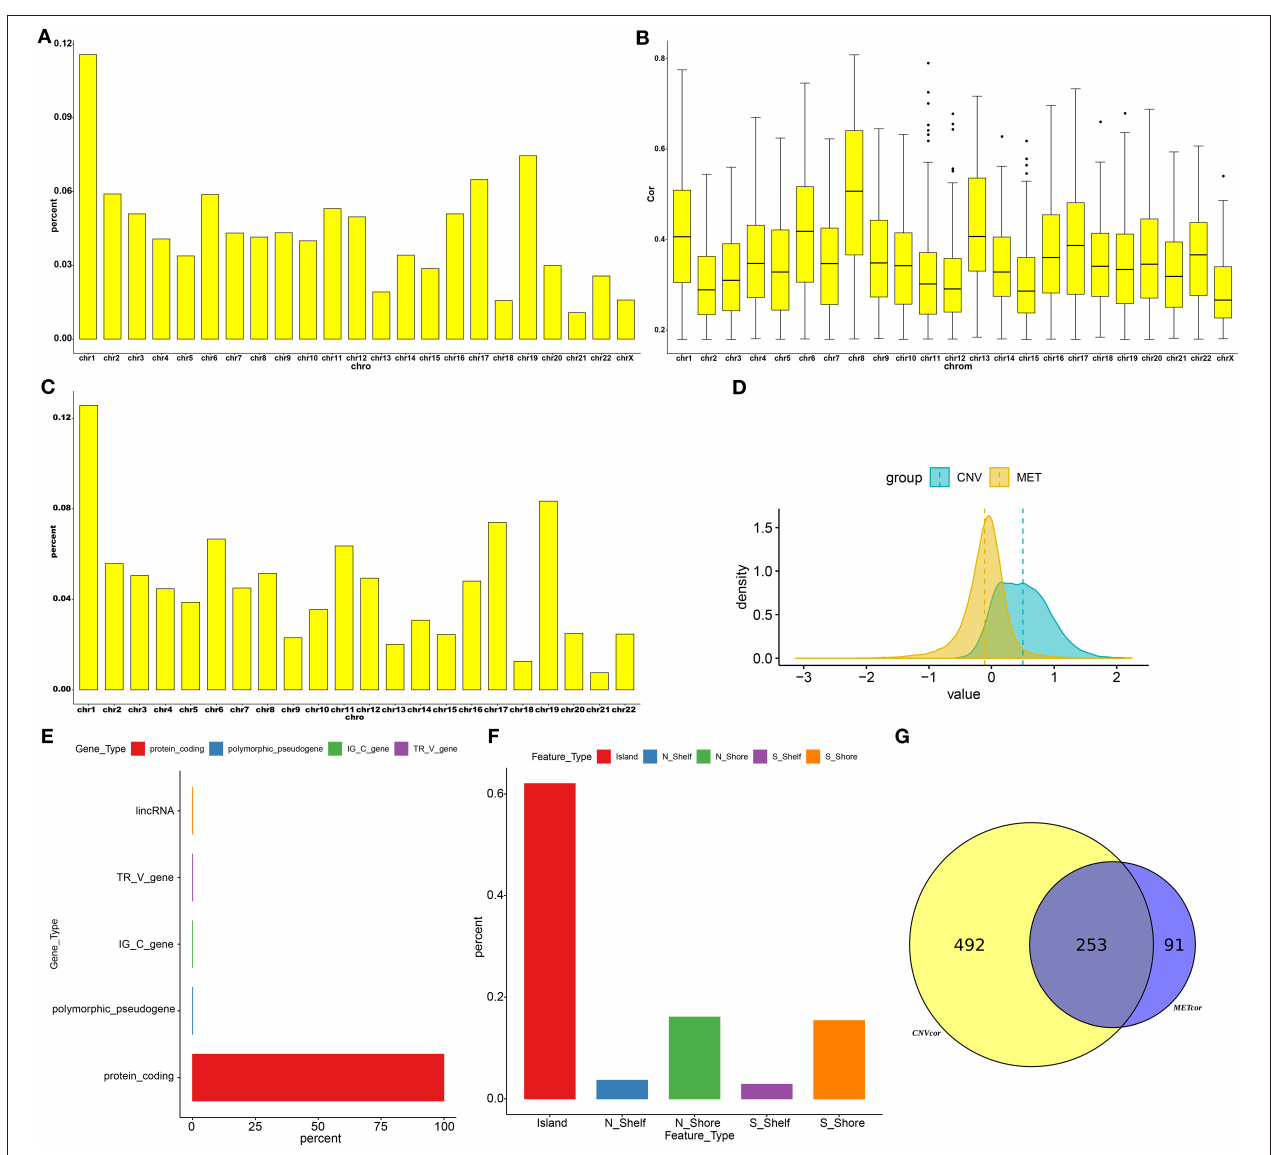
FIGURE 1 | Screening CNVCor and METCor genes in liver cancer. Chromosomal distributions (A) and correlations (B) of CNVcor genes. Horizontal axis indicates chromosomes; ordinate axis represents the proportion or the correlation coefficients of CNVcor genes. The middle line of the box plot is the median of the data, which represents the average level of the sample data. The upper and lower limits of the box plot are the upper quartile and the lower quartile of the data. Black dots represent outliers. (C) Chromosomal distribution of METcor genes. Y-axis represents the proportion of METcor genes. (D) Distribution of z-values for CNVcor genes and METcor genes. Horizontal axis is z value correlation, and ordinate axis is the density distributions corresponding to z values. (E) The proportion of each METcor gene type. (F) The proportion of each methylation locus. (G) Venn diagram showing overlapping survival-related CNVcor genes and METcor